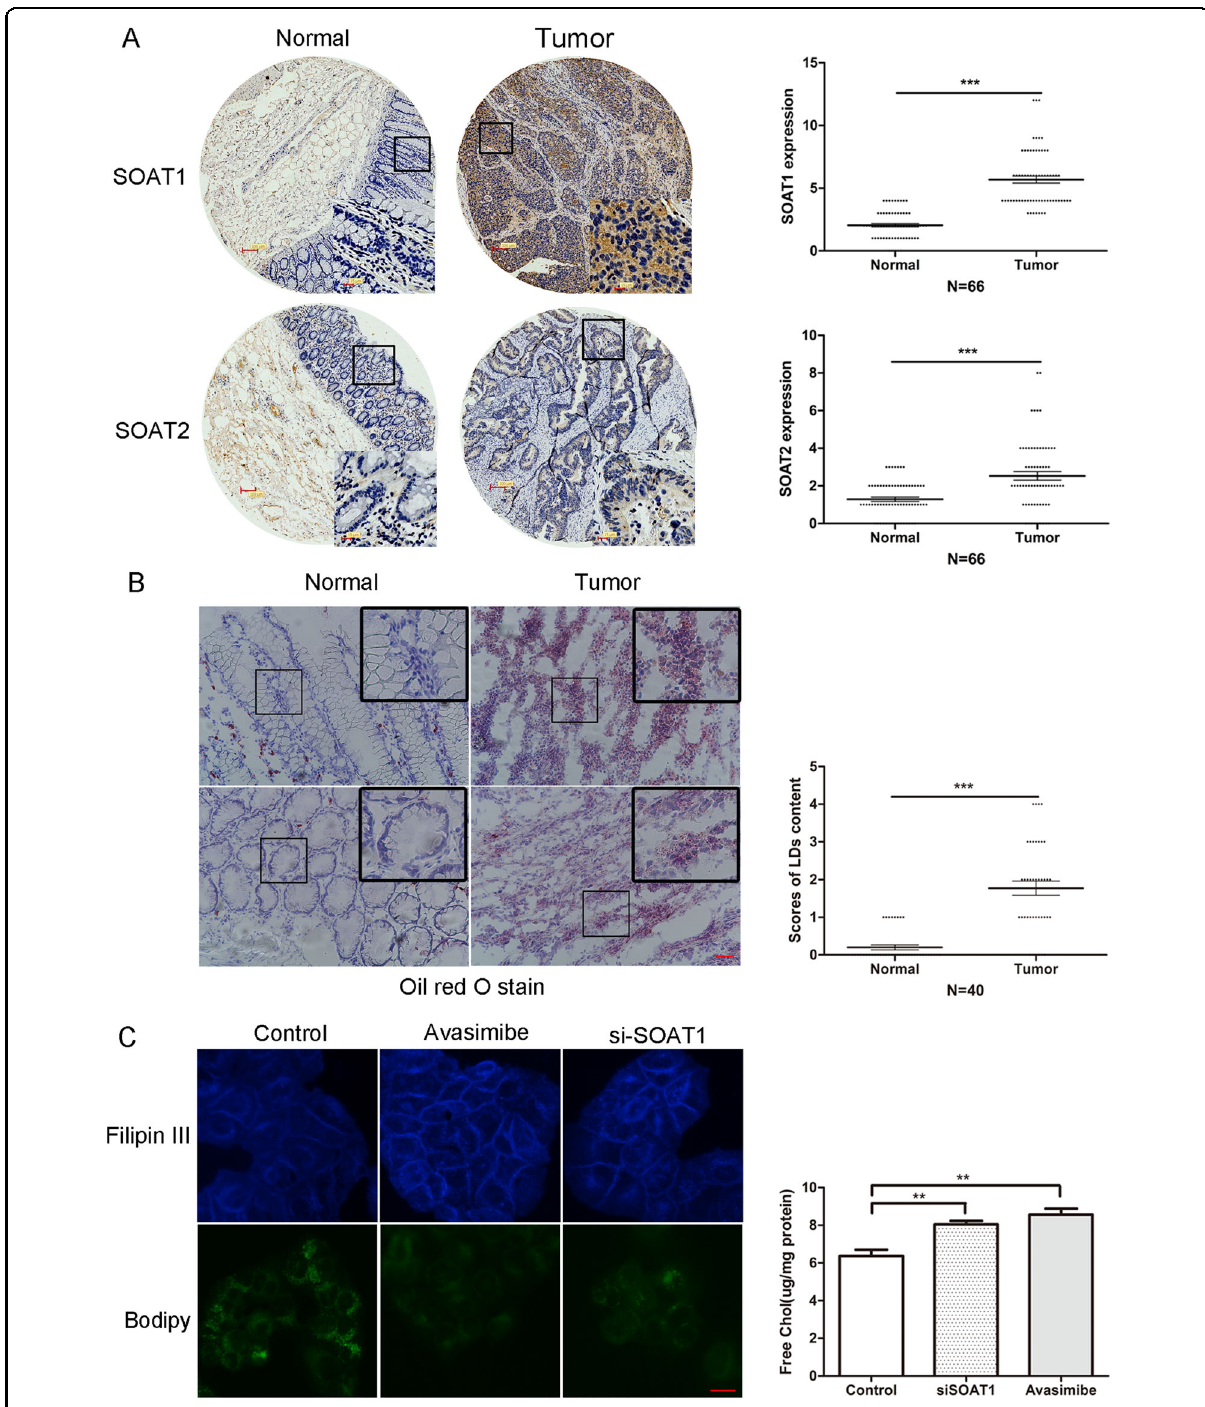
Fig. 1 SOAT1 is highly expressed in colon cancer. A Representative pictures of SOAT1/2 staining in clinical samples of normal and colon cancer tissues. The graphs indicate the IHC scores of SOAT1/2 expression. *** p < 0.001 using Student ’ s t test (two-tailed). Scale bar: 100/15 μ m. B Detecting lipid droplets in 40 pairs of colon cancer tissues and normal tissues by Oil Red O staining. The graph indicates statistical result of lipid droplet content scores. *** p < 0.001 using Student ’ s t test (two-tailed). Scale bar: 50 μ m. C SW1116 cells were transfected with SOAT1 siRNA for 48 h or treated with avasimibe 10 μ M for 16 h, and then stained by Filipin III. The graph indicates the quantitative result of intracellular cholesterol content. ** p < 0.01 using Student ’ s t test (two-tailed). Scale bar: 20 μ m; SW1116 were transfected with SOAT1 interfering RNA for 72 h or treated with avasimibe 10 μ M for 24 h. Bodipy 493/503 was used for lipid droplets